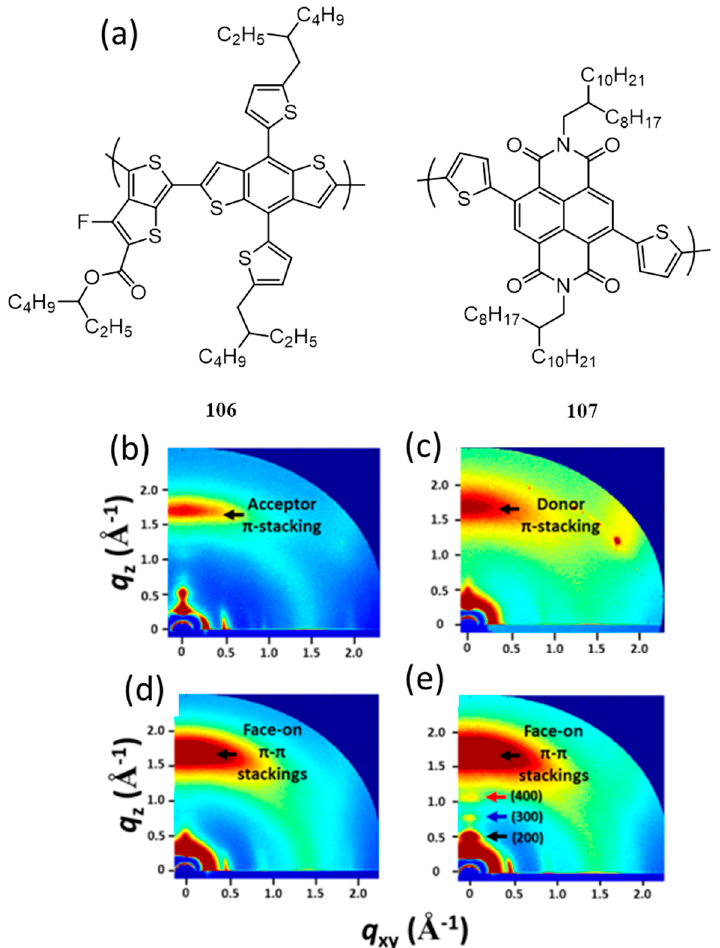
Figure 36. ( a ) Chemical structure of polymers ( 106 and 107 ) synthesized by Kim et al. [121]. 2D-GIXRD images of ( b ) 107 ; ( c ) 106 , 106 / 107 blend (1.3:1) films ( d ) without DIO; and ( e ) with DIO. Adapted with permission from Ref. [121] Copyright 2014 American Chemical Society.